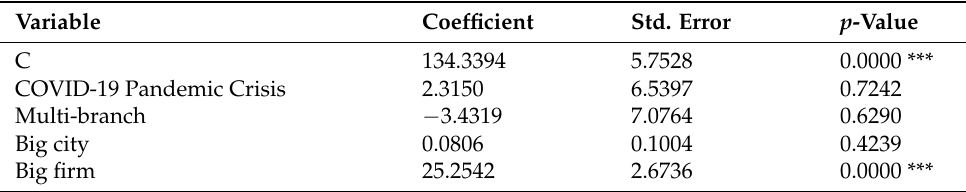
Table 8. The results of the seventh research model.